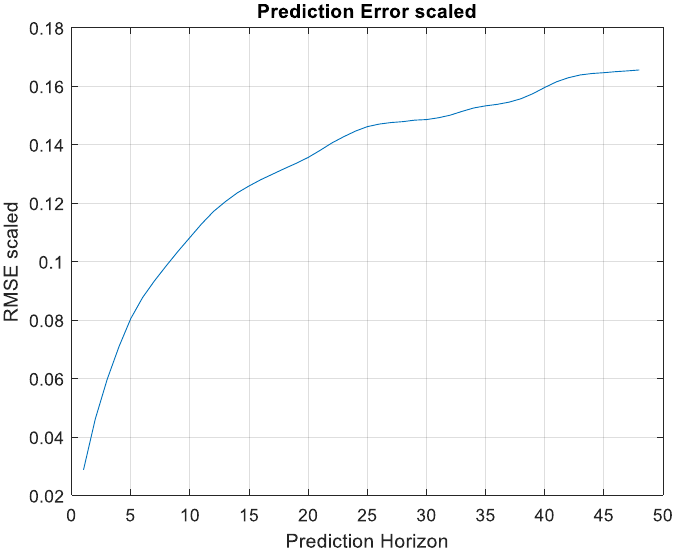
Figure 9. RMSEs of the scaled air temperature within the prediction horizon.